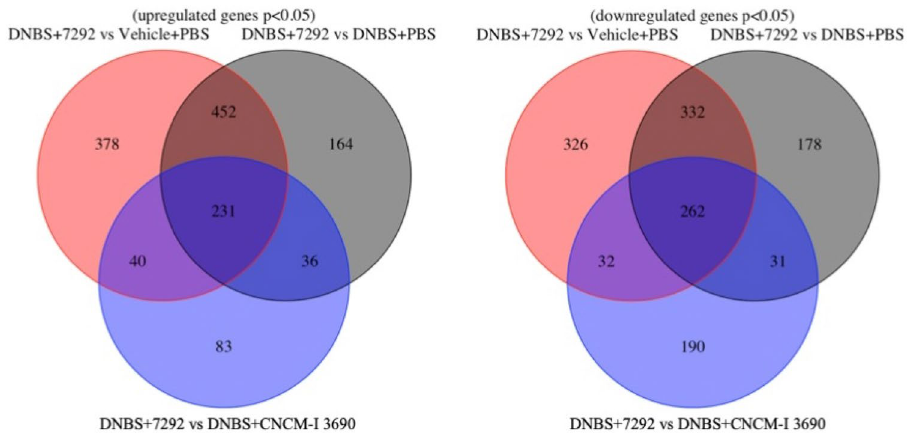
Figure 10. Venn diagram showing the number of unique and shared upregulated (A) and downregulated (B) genes as identified via IPA in the murine model after treatment with the variant 7292. Gene number were compared with those modulated after treatment with the wild-type L. rhamnosus CNCM I-3690, not-treated, and mice administered with the vehicule. Significance: * p < 0.05.